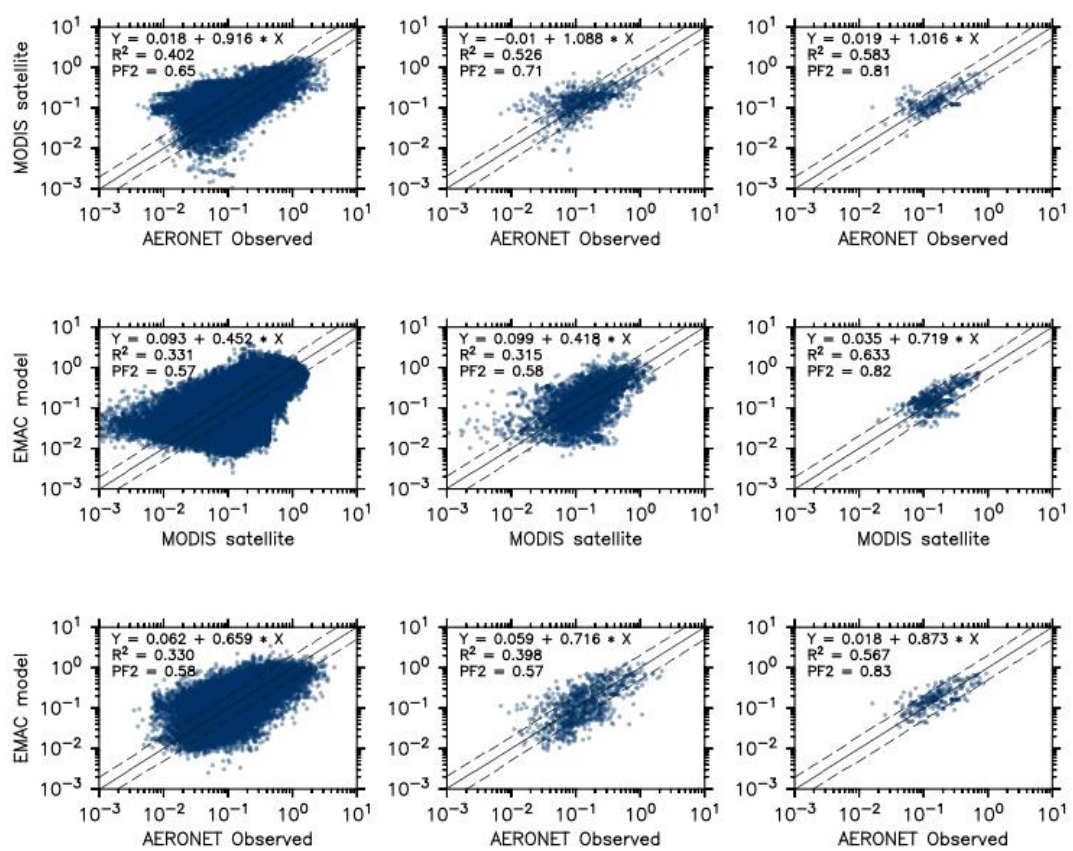
Figure 17. Scatterplots of AOD estimated by the EMAC model in this study versus the MODIS and the AERONET observations. The left, middle and right columns show scatterplots using daily, monthly and annual averages, respectively. Both model- and satellite-based observations were sampled at the AERONET locations. In each plot the coefficients of the linear fit, the coefficient of determination and the fraction of data within a factor of 2 are